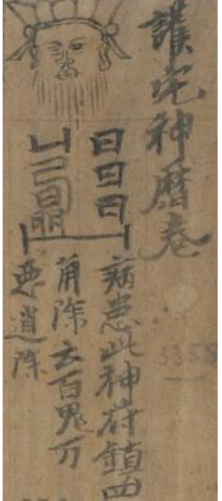
Figure 1. The first amulet on P.3358 (detail). The manuscript (one leaf extant) is titled Hù zhái shén lì juàn 護宅神曆卷 ( “ fascicle on deities protecting the residence ” ) and contains several fú protecting the inhabitants of residences. The protection is, for example, against diseases, problems during childbirth, etc. (copyright: Bibliothèque Nationale, Paris).